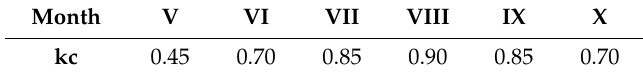
Table 2. Crop coe ffi cients (kc) for grapevine according to Doorenbos and Pruit [16]. Month V VI